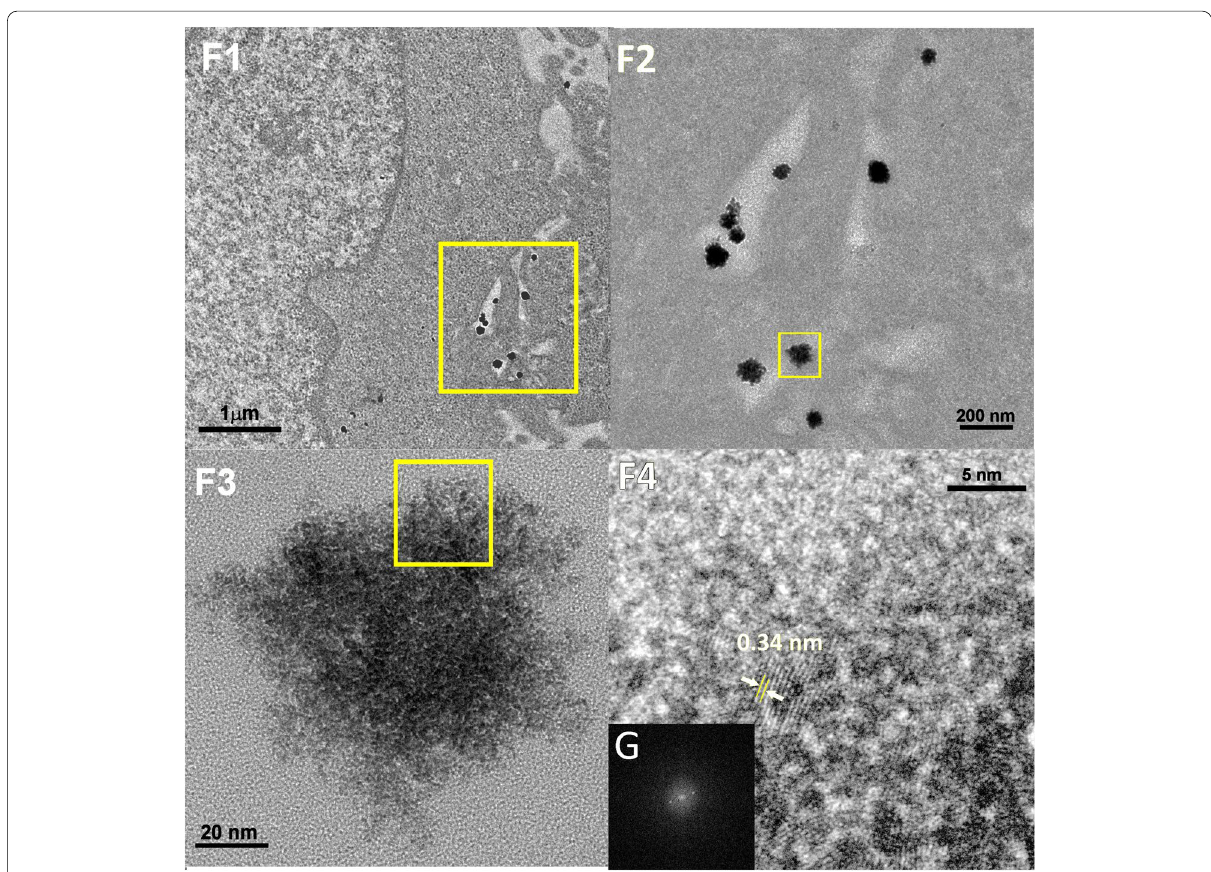
Fig. 6 PET‑NPs internalization (magnification). TEM micrograph detailed magnification from Fig. 5‑F, of PET‑NPs internalized by RAW 264.7 cell line ( F1 , F2 , F3 , F4 ). Yellow squares indicate the sequence of magnification zone and white arrows point out the planar distance of PET semicrystalline ( F4 ), and its FTT diffraction pattern ( G )